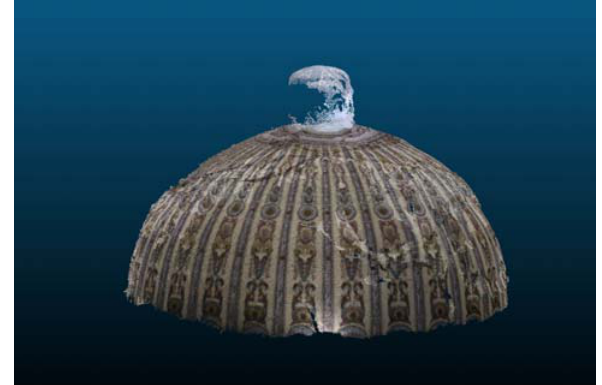
Figure 9:ODM dense point